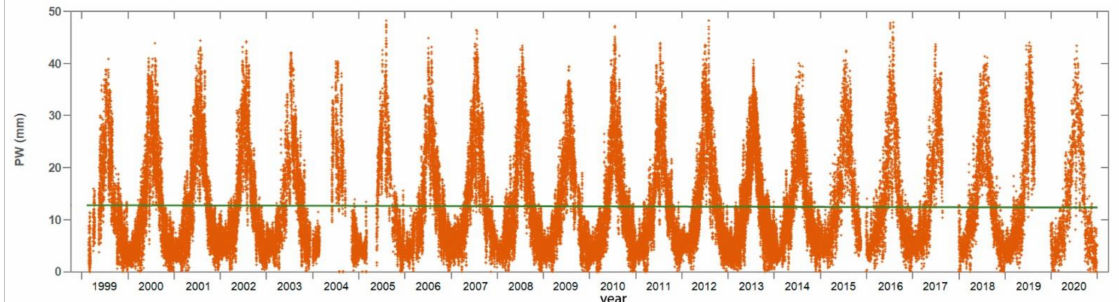
Figure 6. Time series of measured PW values at the IRKM for the period 1999—2020. The green line is the general linear